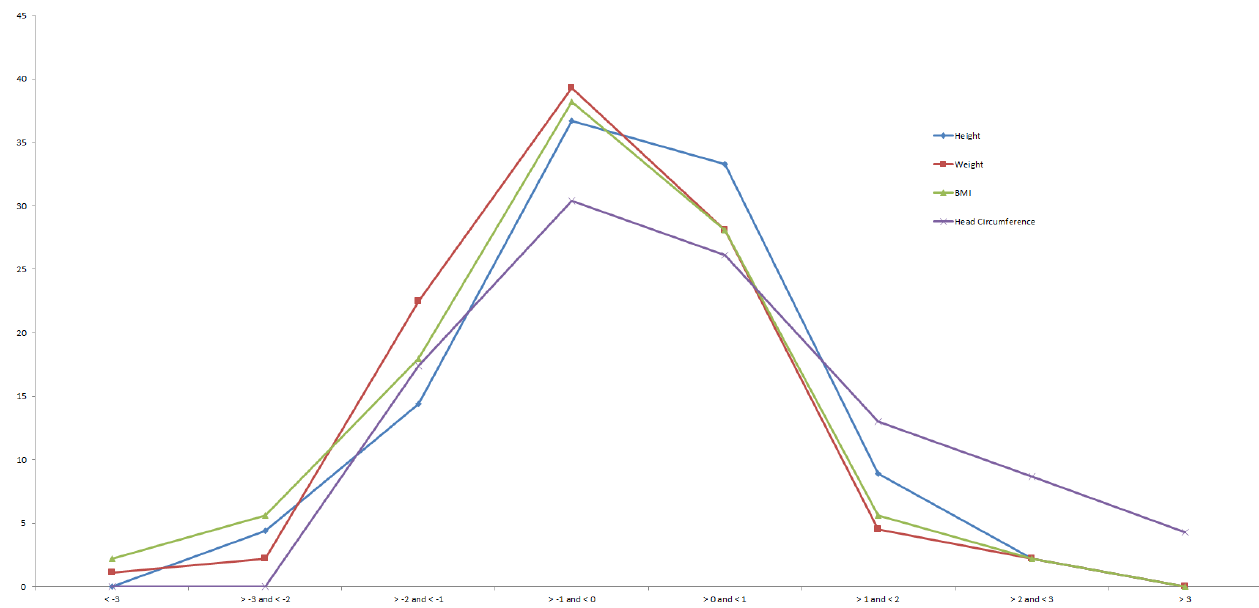
Figure 1. Distribution of weight, height, and body mass index for age, according to World Health Organization standardized growth curves. Y-axis is number of children (n=96). X-axis is z-score.